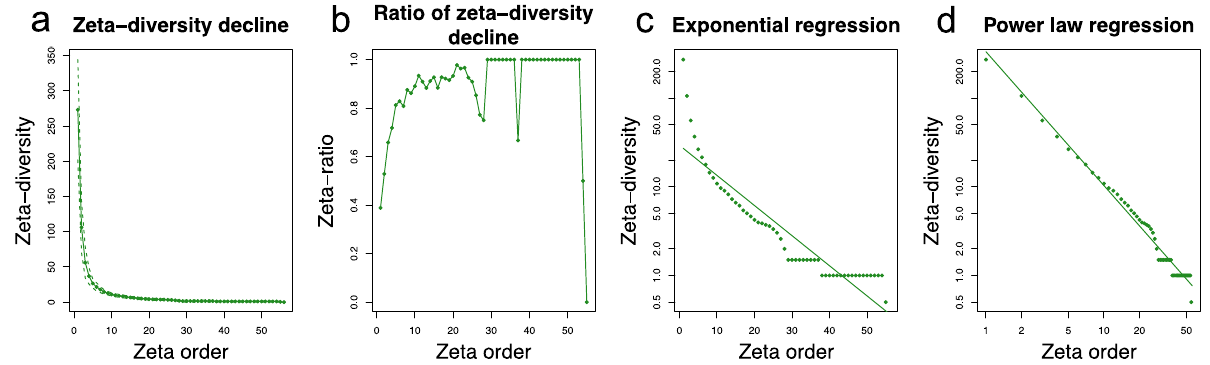
Fig. 4 Zeta-diversity decline and model fi tting on the insect fauna for nearest-neighbour combinations and assemblages. Zeta-diversity analyses per zeta order (i.e. ζ i ) here referring to plots (from ζ 2 to ζ 56) for two computing schemes. Representations consider model scheme that computes nearest- neighbour plot combinations and assemblages (NN) with parameter sample set to 5000 and Monte – Carlo (mc) sampling. a , b Zeta-diversity decline and 0 to 1 scaled ratio of zeta-diversity decline, representing species shared and species retention rate (i.e. the retention probability of common species in the community) across ζ i , respectively. Zeta-diversity decline curve ( a ) indicated high heterogeneity in insect diversity across the studied plots as fewer and fewer species were shared between 2 – 9 plots and almost no common species were being shared when 10 plots or more were considered. Zeta ratio ( b ) highlighted the high prevalence of the few species shared across 2 – 54 plots that were likely to be sampled, and the drop of species retention rate at zeta order ζ 28 corresponded to geographic distance between the two sampled districts. c , d zeta-diversity model fi tting to exponential and power-law regressions, respectively. Fit to exponential regression implies equal and stochastic turnover among species whereas fi t to power-law regression as represented here indicates turnover driven by niche differentiation processes and rare species less likely to be found across the whole